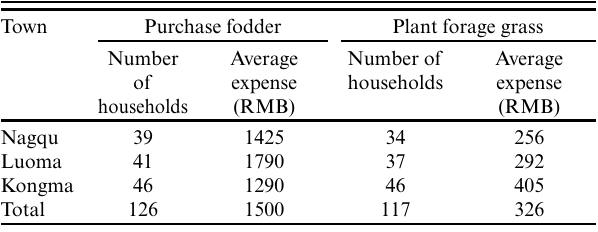
Table 6 . Local herders’ adaptive activities to maintain forage